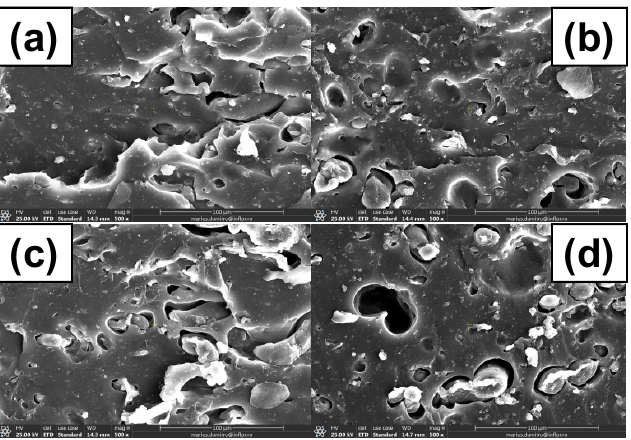
Figure 12. C50 SEM micrographs at magnification of 500: ( a ) un-irradiated, ( b ) irradiated at 150 kGy, ( c ) irradiated at 300 kGy, ( d ) irradiated at 450